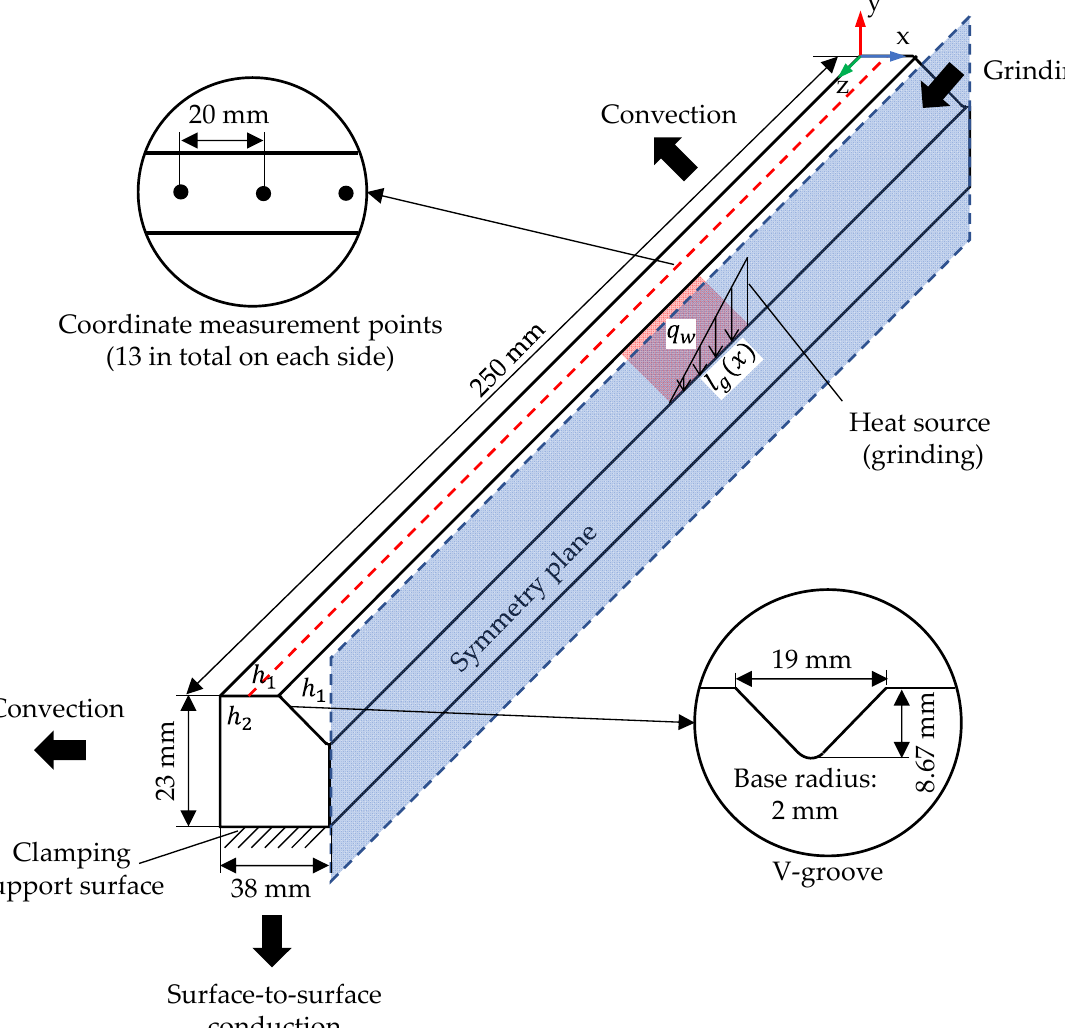
Figure 2. Workpiece set-up for the grinding process and the applied boundary conditions, with heat transfer coefficients and grinding contact zone for the simulation of the symmetric workpiece model .